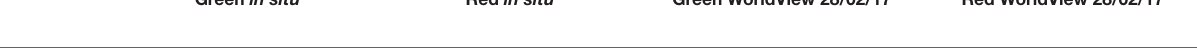
Frontiers in Plant Science |